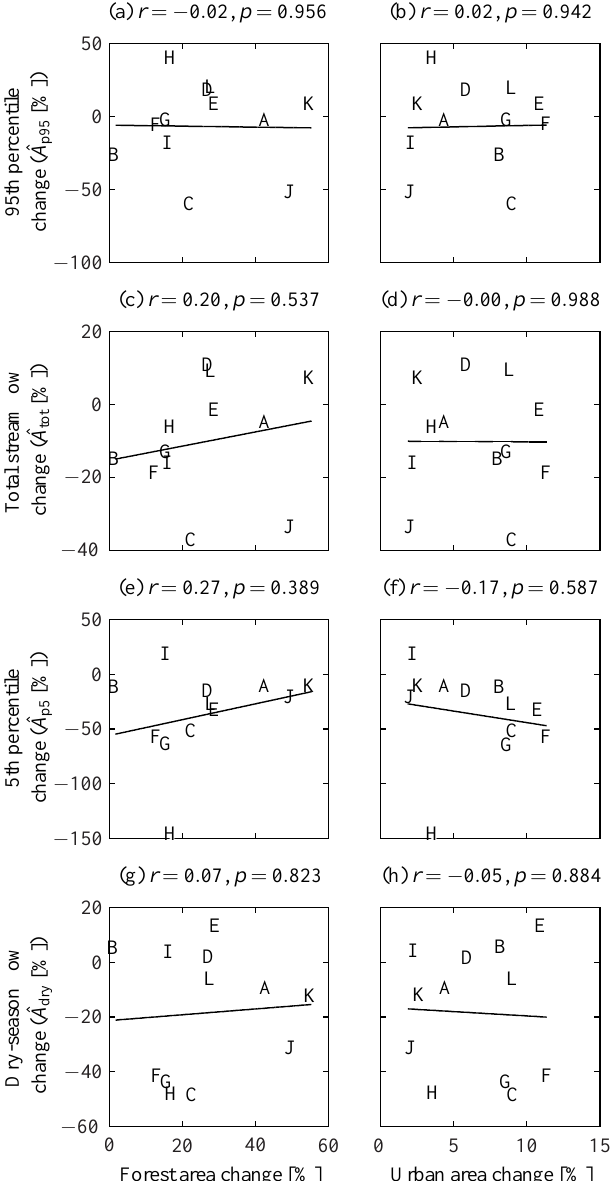
Fig. 7. Net changes in forest and urban areas plotted against A p95 (a–b) , Q tot (c–d) , Q p5 (e–f) , and Q dry (g–h) values (Eq. 5; Table 5). Each letter in the scatter plots represents a different catch- ment. The change covers the start of the record (cf. Table 1) until